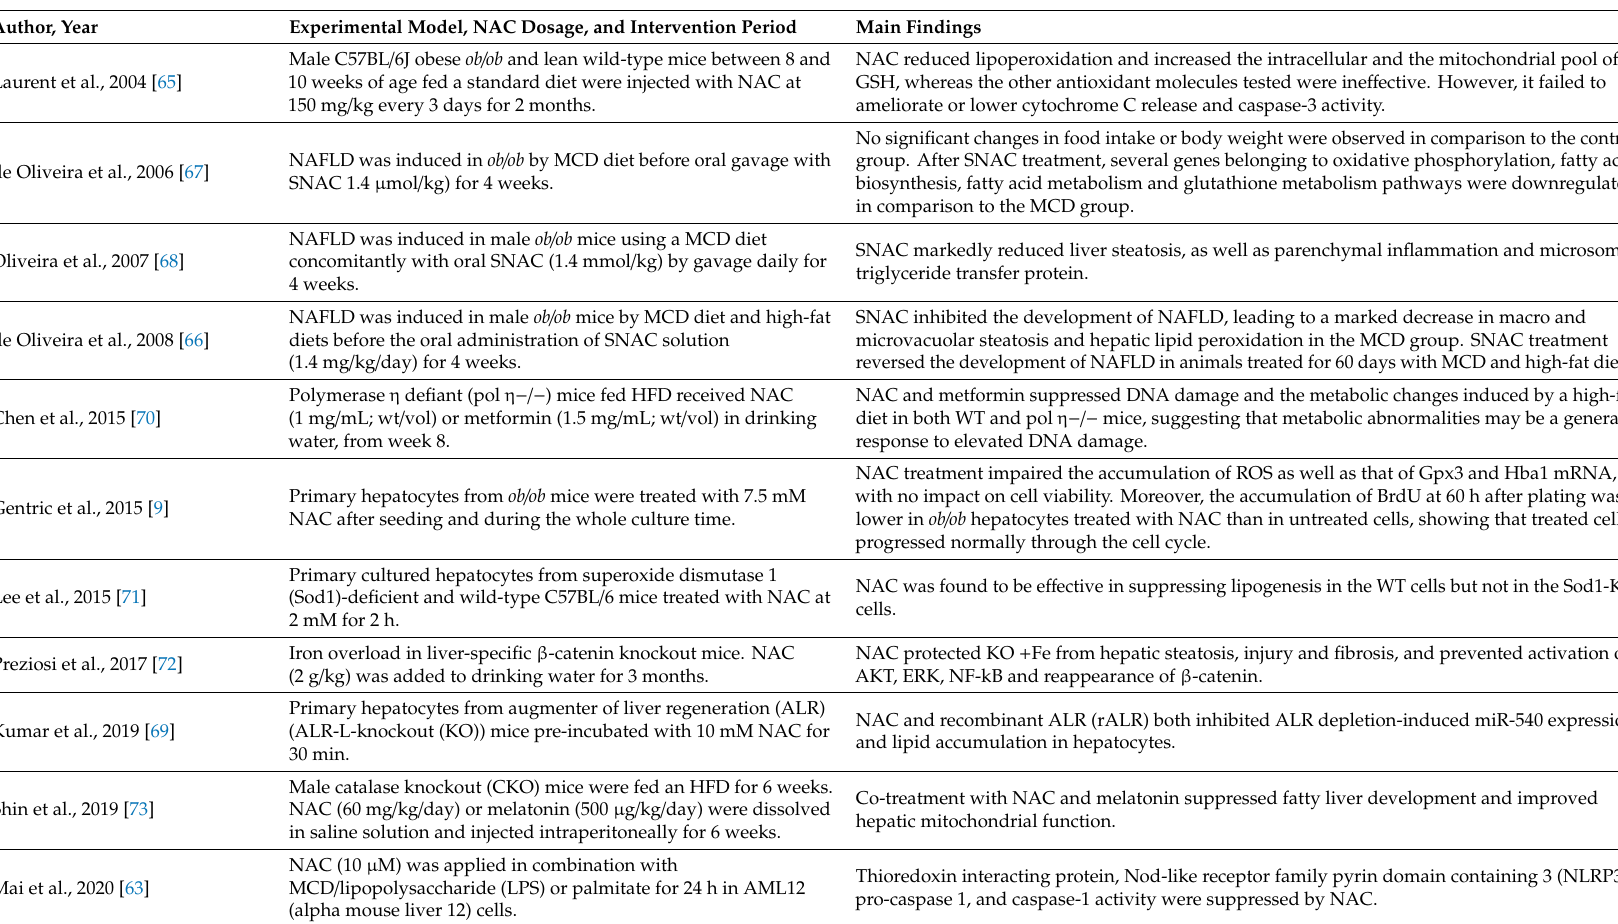
Table 3. An overview of the literature on the impact of NAC on lipid accumulation, oxidative stress and inflammation in knockout models of